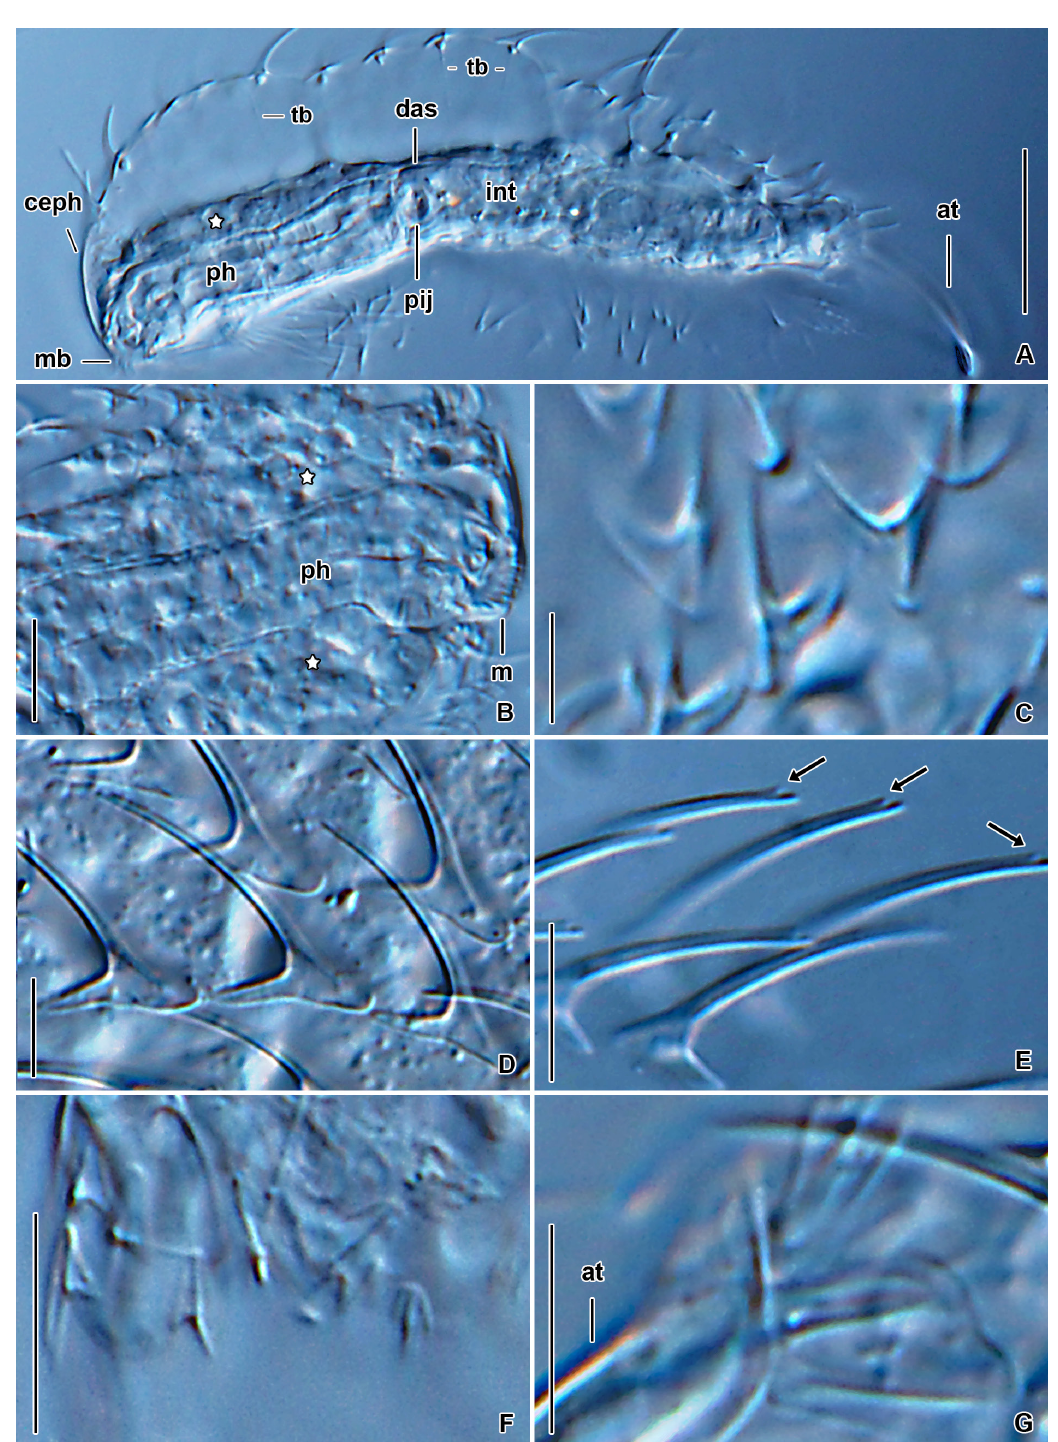
Fig. 30. Chaetonotus ( Hystricochaetonotus ) luxus sp. nov., differential interference contrast. A, E . Paratype (CU-FNS-17-02-20/PA-1). B–D, F–G . Paratype (CU-FNS-17-02-20/PA-2). A . Lateral overview showing the internal morphology. B . Anterior body region. C . Head scales. D . Dorsolateral trunk scales. E . Lateral view of dorsal trunk spined scales carrying a minute lateral denticle (arrows). F . Ventral furcal scales. G . Dorsolateral oblong scales lining the furca sides. White stars in (A) and (B) mark the cerebral ganglion. Scale bars: A = 15 µm; B, E = 10 µm; C–D, F–G = 5